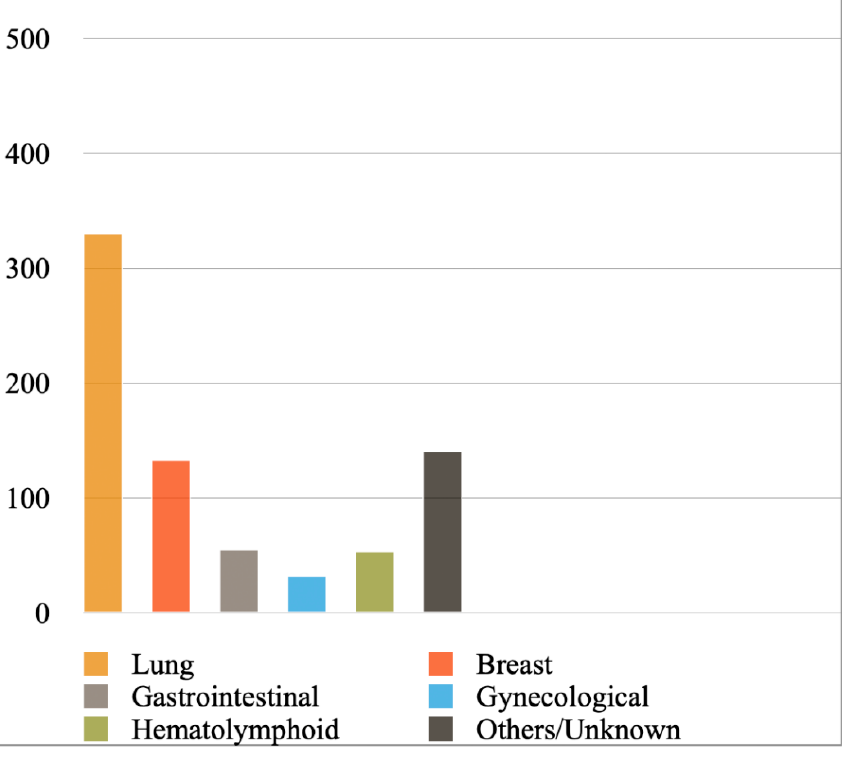
Figure 3. Most prevalent cancer primaries in malignant pericardial effusions diagnosed exclusively with